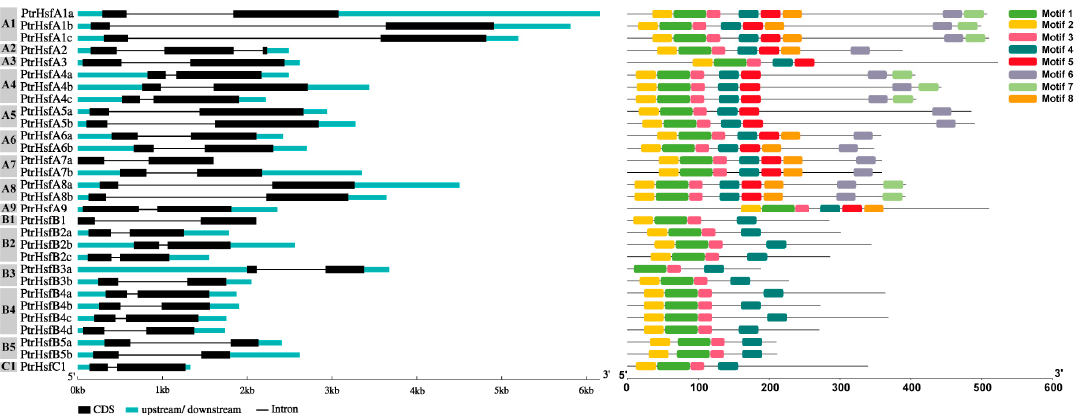
Figure 4. DNA structure and protein motifs of poplar HSF family members. Exons and the 5’ UTR/3’ UTR are shown in black and cyan bars. Black lines indicate introns. Different motifs are represented by boxes with specific colors. The proteins were ranked according to their